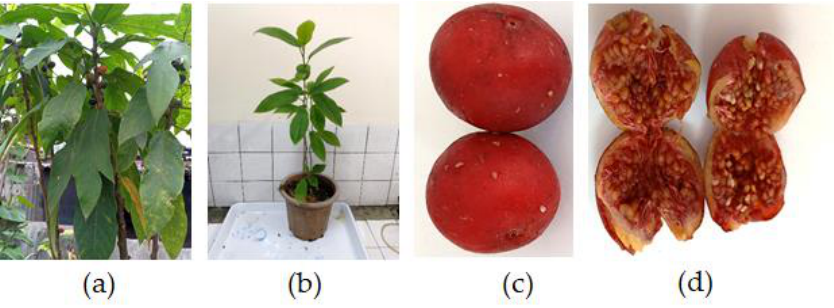
Figure 1. Sample image of Ficus simplicissima Lour. m3 regenerated from seeds collected in the Thai Nguyen province (Hung Son township, Dai Tu district). ( a ) Plants regenerated in vitro from seeds grown in the experimental garden and ( b ) grown in pots, they are kept at the Department of Biology, Thai Nguyen University of Education; ( c , d ) fruit of F. simplicissima.